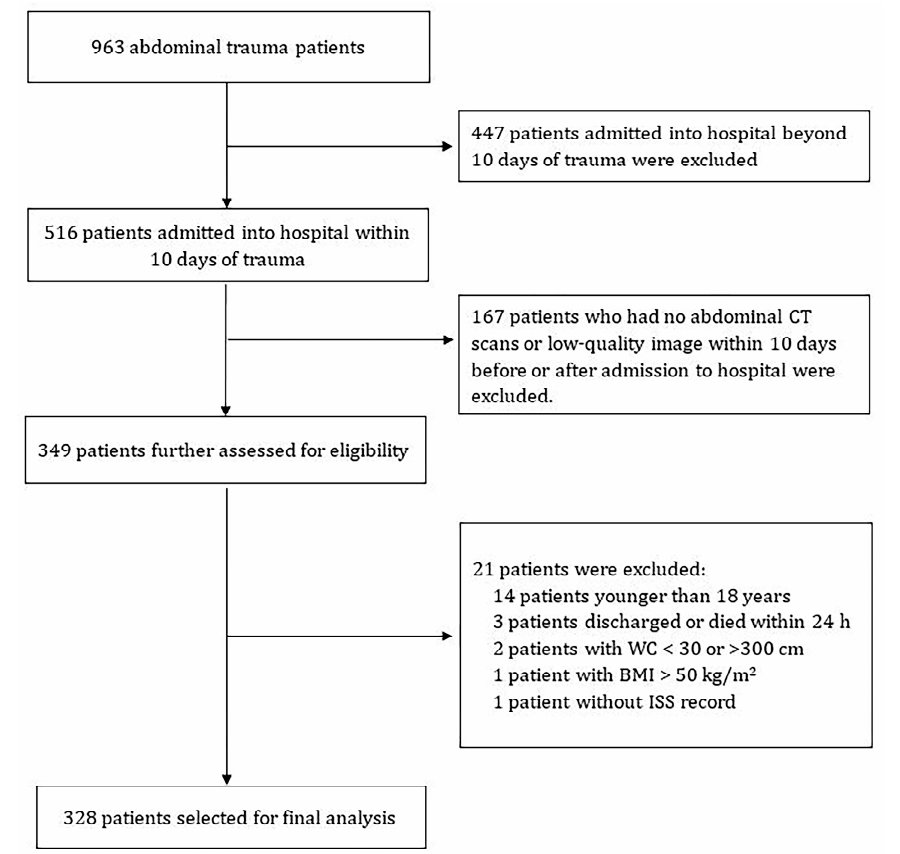
Figure 1. Flow chart of the included participants. CT, computed tomography; WC, waist circumfer- ence; BMI, body mass index; ISS, injury severity score.